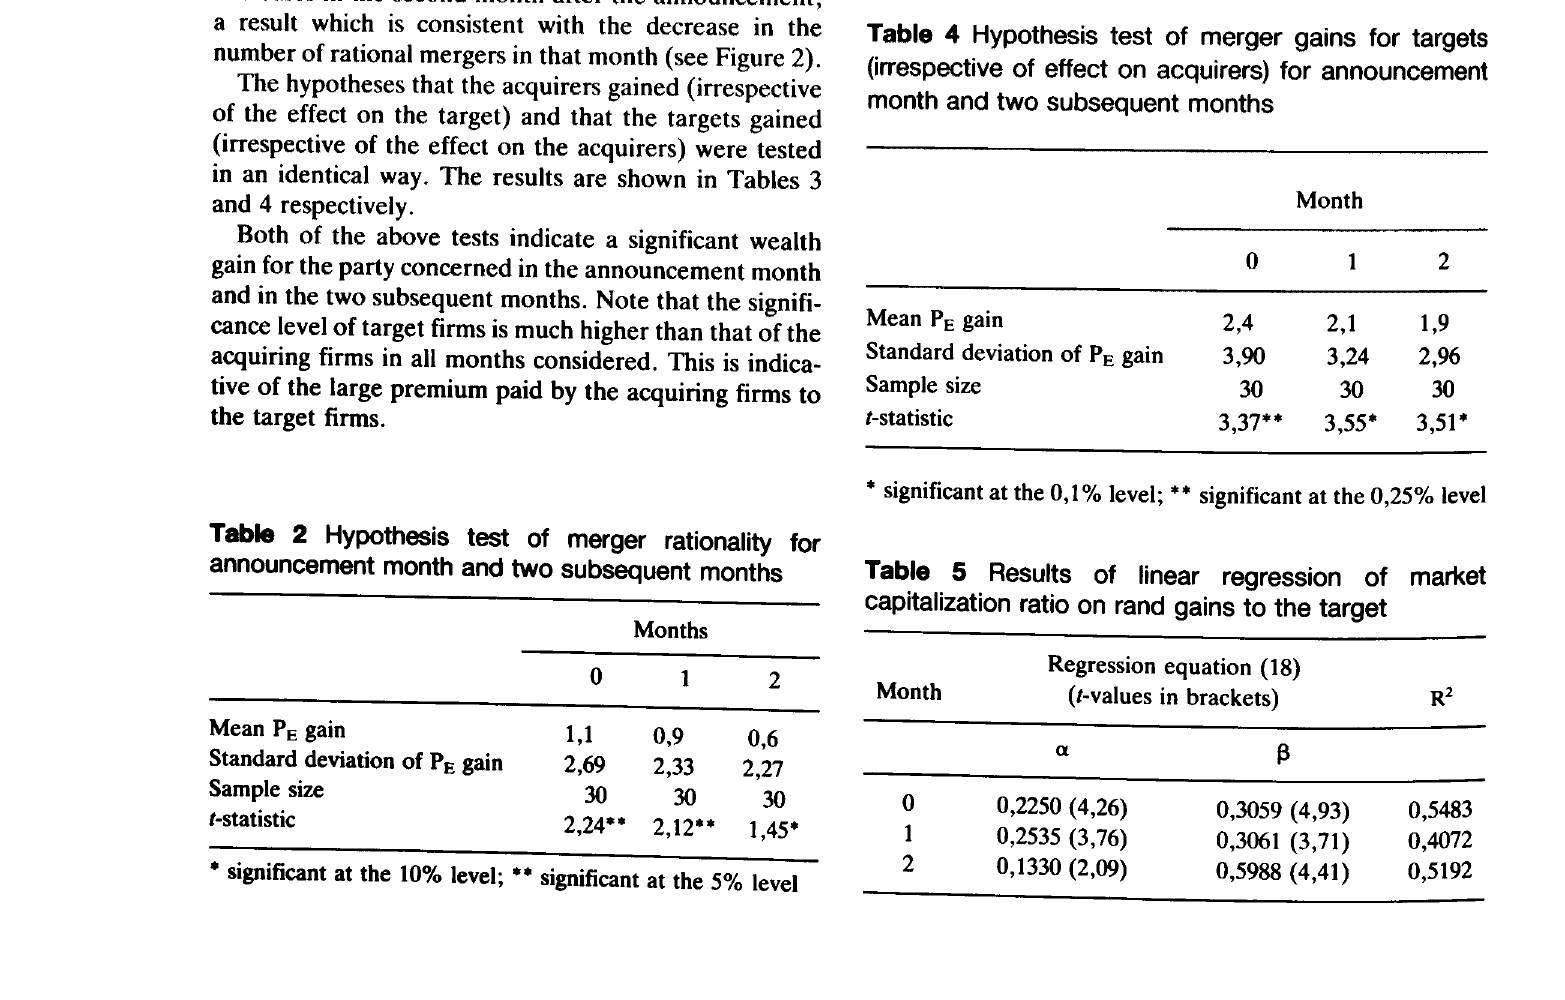
Table 2 Hypothesis test of merger rationality for announcement month and two subsequent months